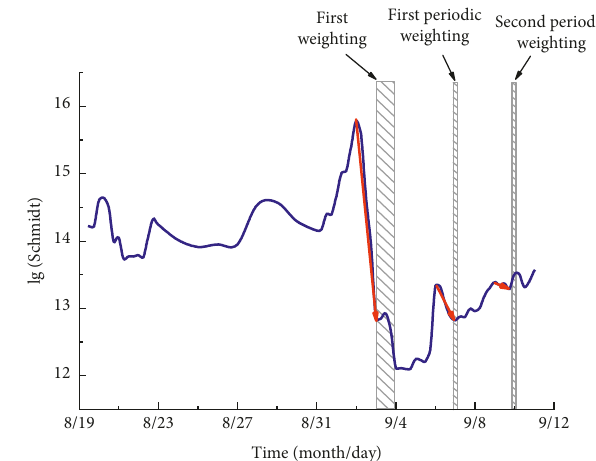
Figure 10: Changes of the MS event number with time.